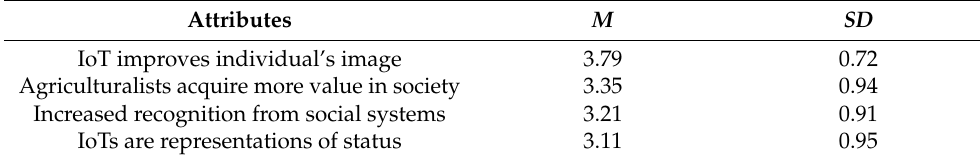
Table 4. Beliefs of Agriculturalists’ Image due to IoT Smart Agriculture ( n =